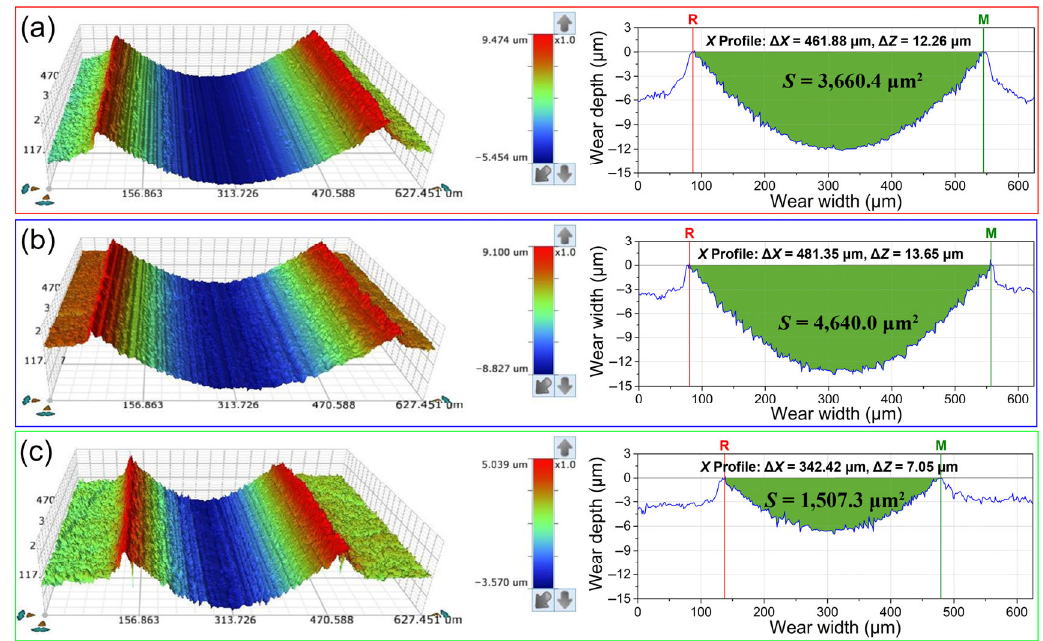
Fig. 13 3D and 2D profiles of wear tracks of the disks lubricated with (a) PEG200, and (b) A-g-CNPs and (c) C-g-CNPs dispersions (0.7 wt%) in PEG200 under the conditions of 100 N and 200 min.